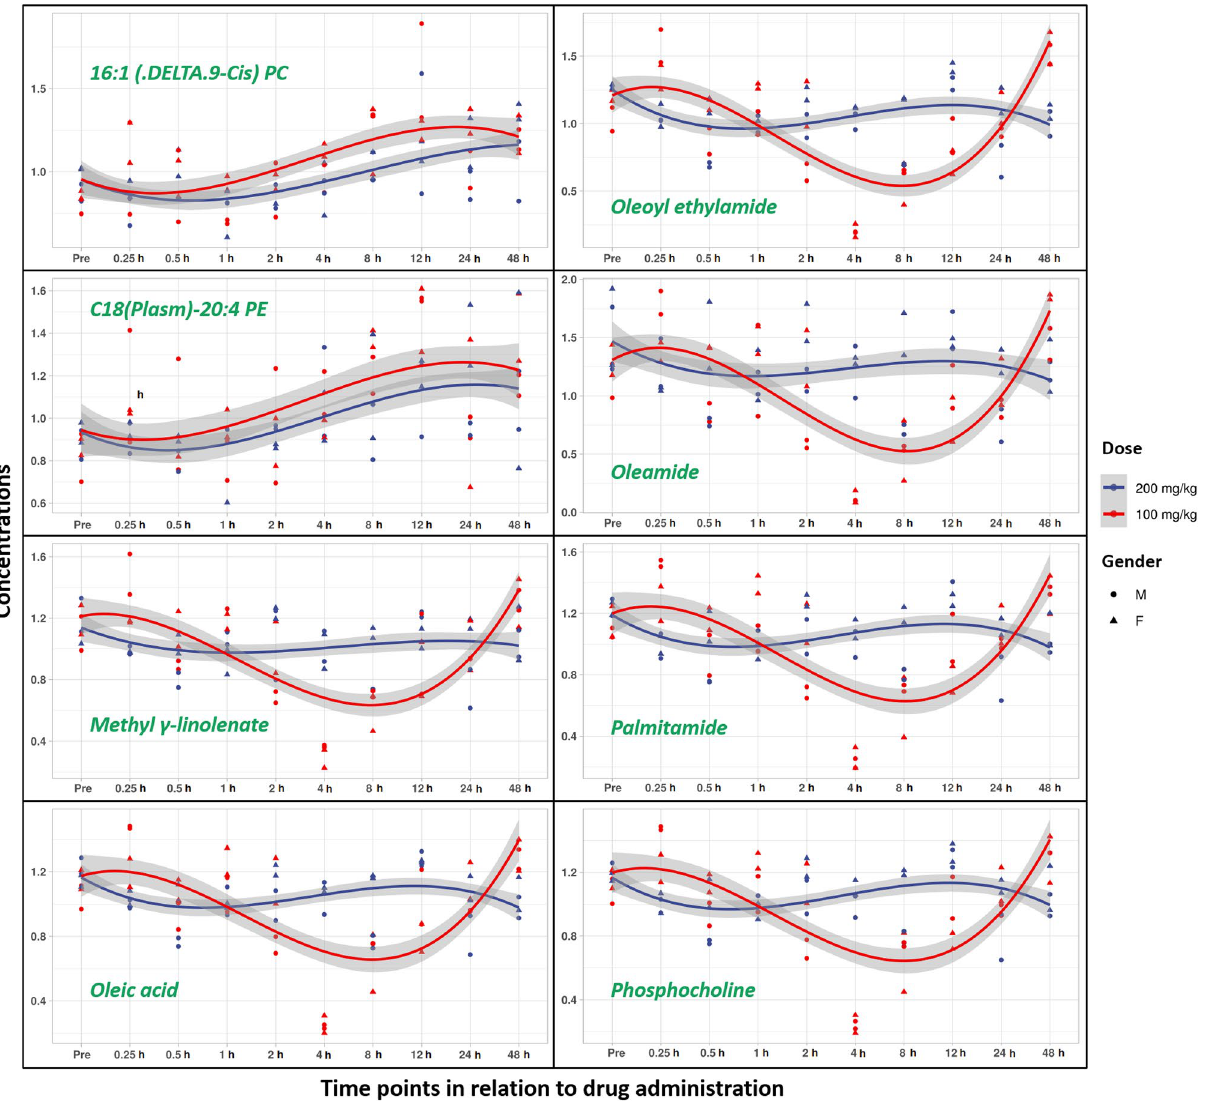
Figure 5. A trend line of the performance of a subset of metabolites/lipids over the study time course showing transient changes that stabilize over